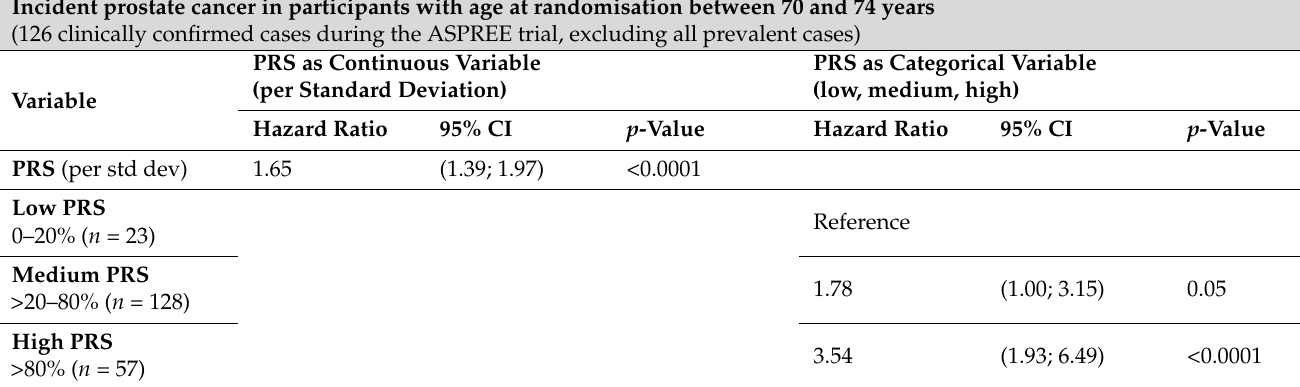
Cox proportional hazards model, adjusted for first degree family history of prostate cancer, age at enrolment, and trial arm